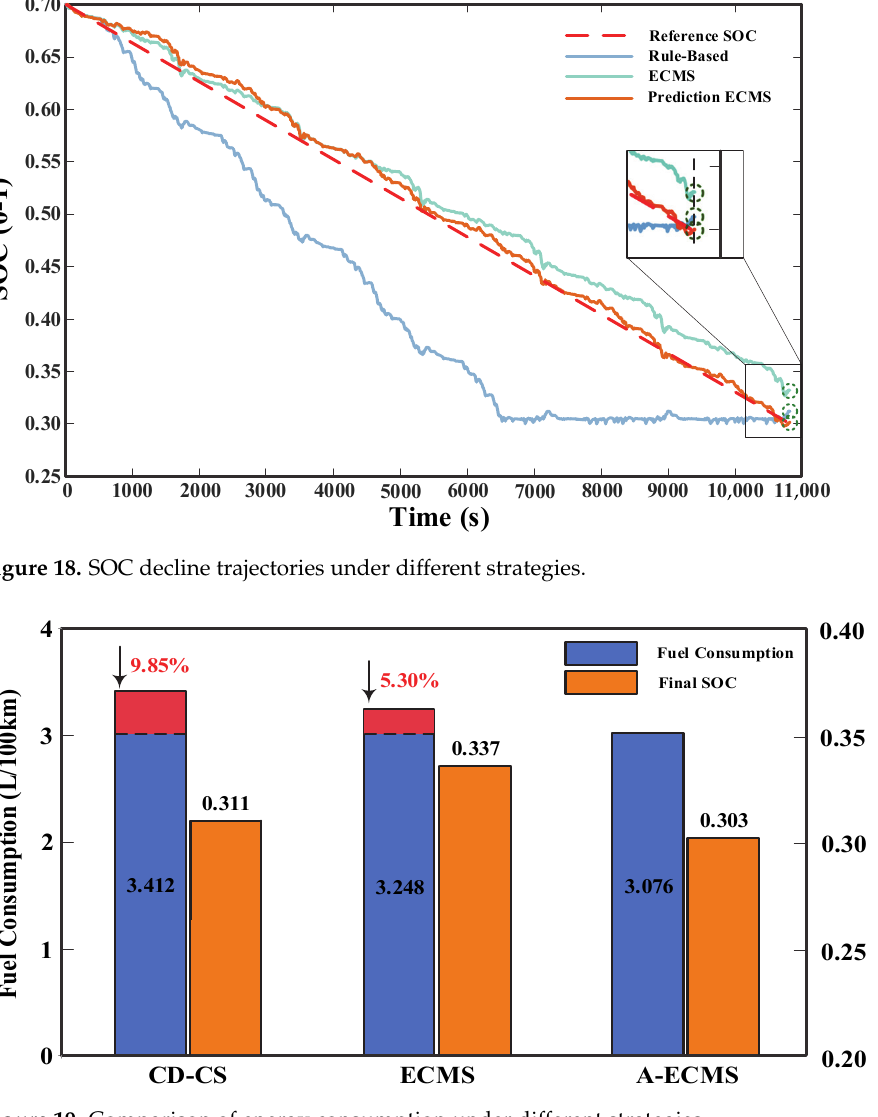
Figure 19. Comparison of energy consumption under different strategies. Table 4. Fuel consumption under different strategies.